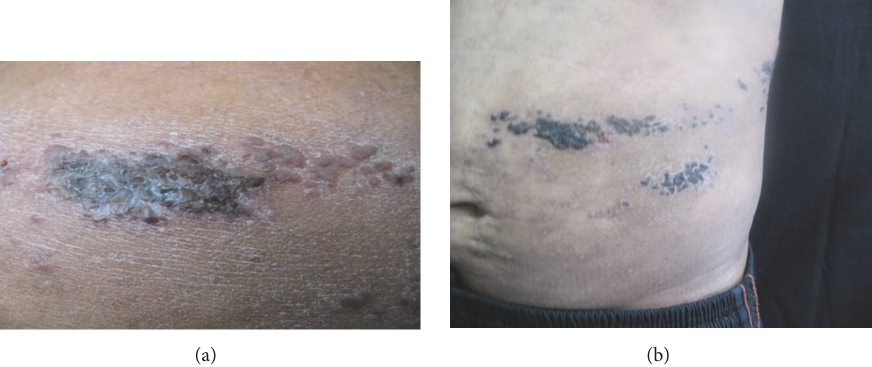
Figure 1: Cutaneous lesions located in left costal dermatome, characterized by multiple necrotic lesions.